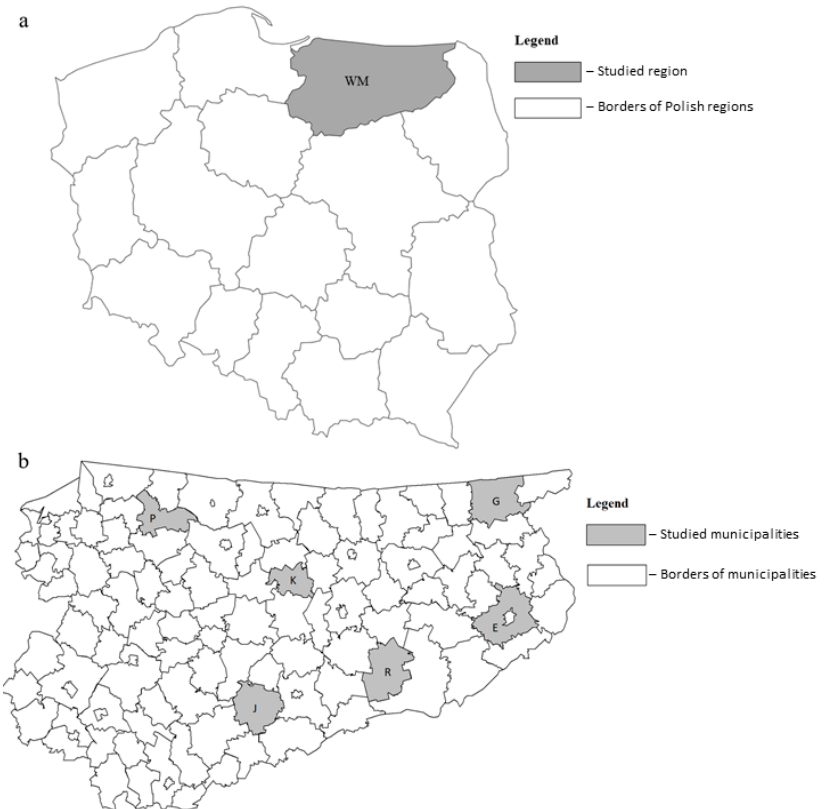
Figure 1. ( a ) Map of Poland and the region of Warmia and Mazury ( b ) with an indication of the municipalities were field studies were performed. Legend: WM = the region of Warmia and Mazury; E = E ł k; G = Go ł dap; J = Jedwabno; K = Kolno; P = Pieni ęż no; R = Ruciane-Nida.